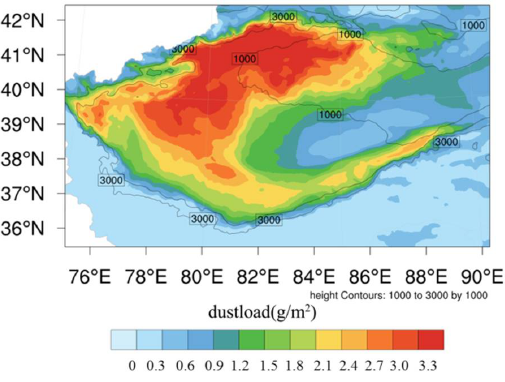
Figure 6. Spatial distribution of the total vertical column dust load in g m −2 over the TB on 30 April 2015, at 01:00 UTC.